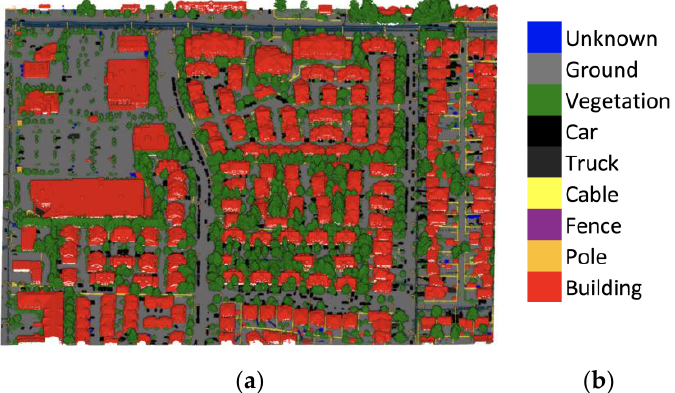
Figure 9. ( a ) DALES point cloud with its eight classes ( b ) legend.